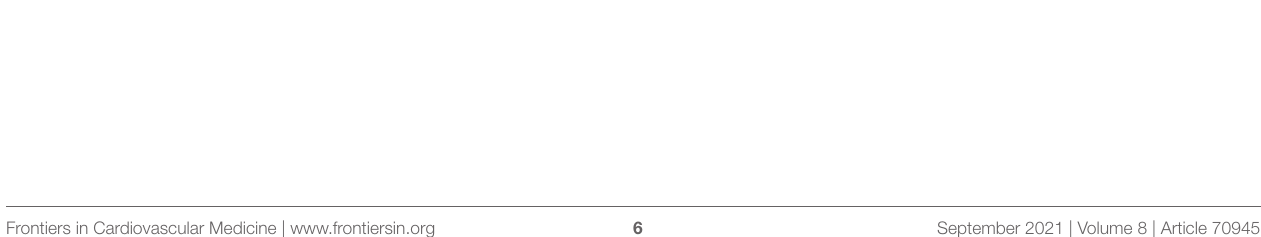
Frontiers in Cardiovascular Medicine |